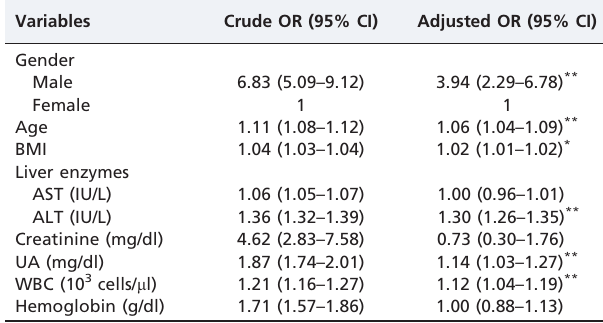
Table 3 - Factors associated with MS according to multiple logistic regression